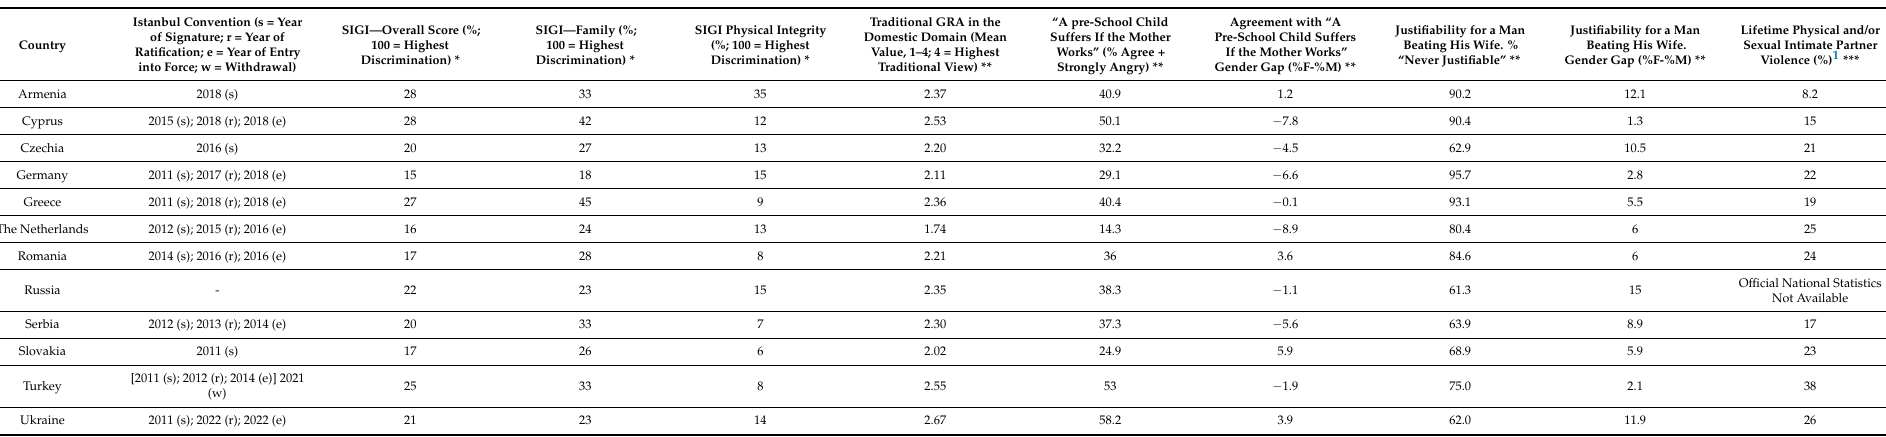
Table 1. Synthetic overview of gender norm indicators by